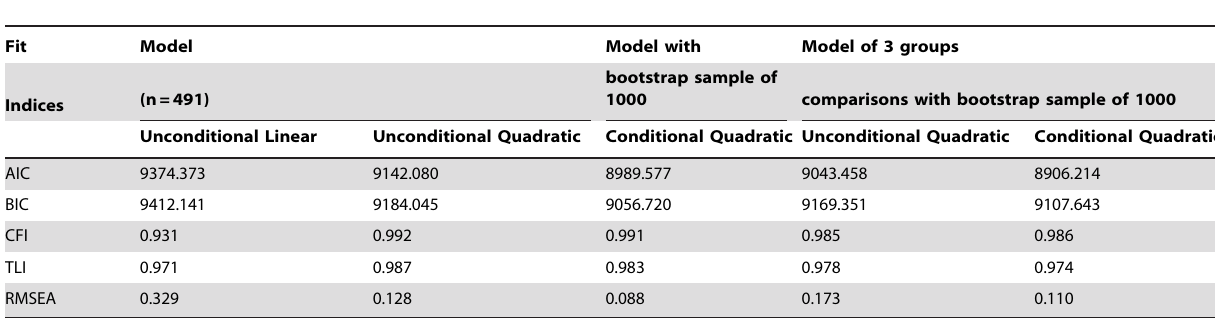
Table 2. Fit indices of linear LGM and Quadratic